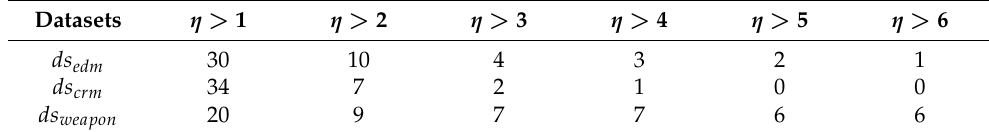
Table 1. Counts of mislabeled attributes in three datasets in a different range of η